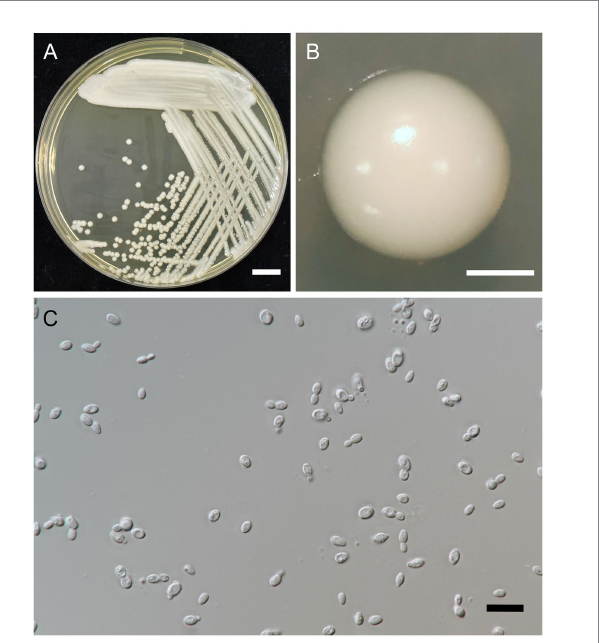
FIGURE 5 Wickerhamiella camelliae FLA5.4 T (=SDBR-CMU428 T , holotype). Culture (A) , single colony (B) , and cells (C) on YMA after incubation at 25 ° C for 3 days. Scale bar A = 1 cm, B = 1 mm, and C = 10 μ